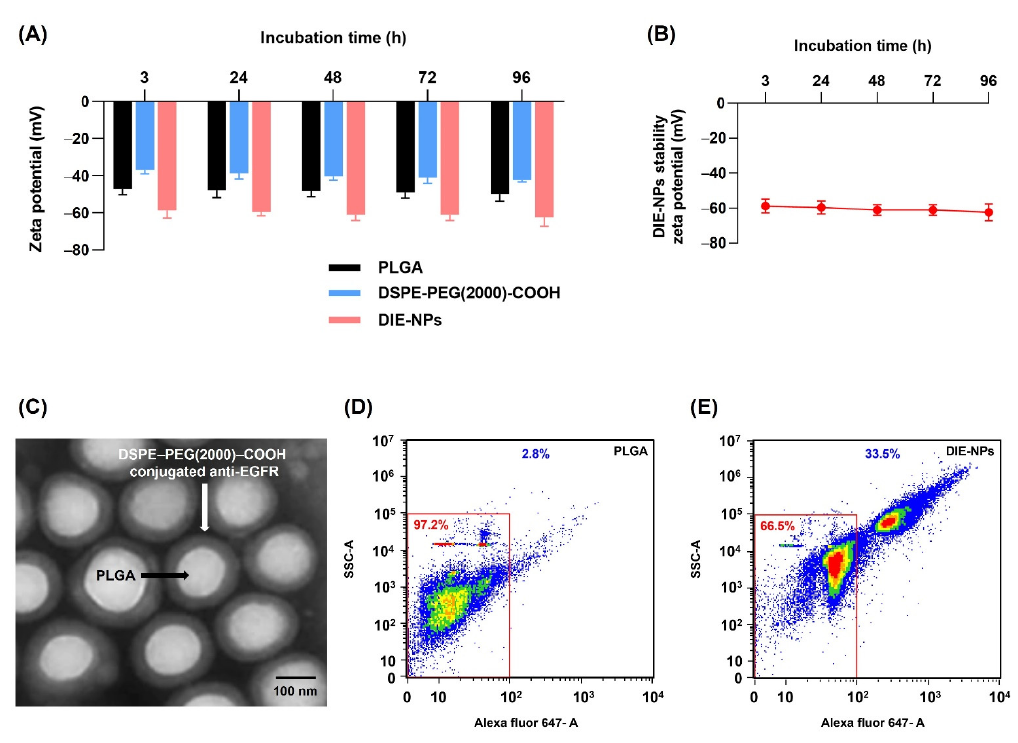
Figure 4. Nanoparticle structural characterization and stability. ( A ) Zeta potential of PLGA, DSPE − PEG(2000) − COOH and DIE-NPs after incubation times of 3, 24, 48, 72 and 96 h. ( B ) DIE-NPs stability zeta potential of DIE-NPs after incubation times of 3, 24, 48, 72 and 96 h. ( C ) Transmission electron microscopy (TEM) image of the DIE-NPs core–shell structure. Scale bar = 100 nm. ( D ) Scatter plot of unconjugated PLGA nanoparticles. ( E ) Scatter plot of conjugated DIE-NPs. The region from flow cytometer evaluated (red line) was adjusted to the upper right corner, which indicates the conjugation of Alexa Fluor 647 anti-human EGFR antibody (fluorescently positive events). Data are given as mean ± standard deviation ( n = 3).